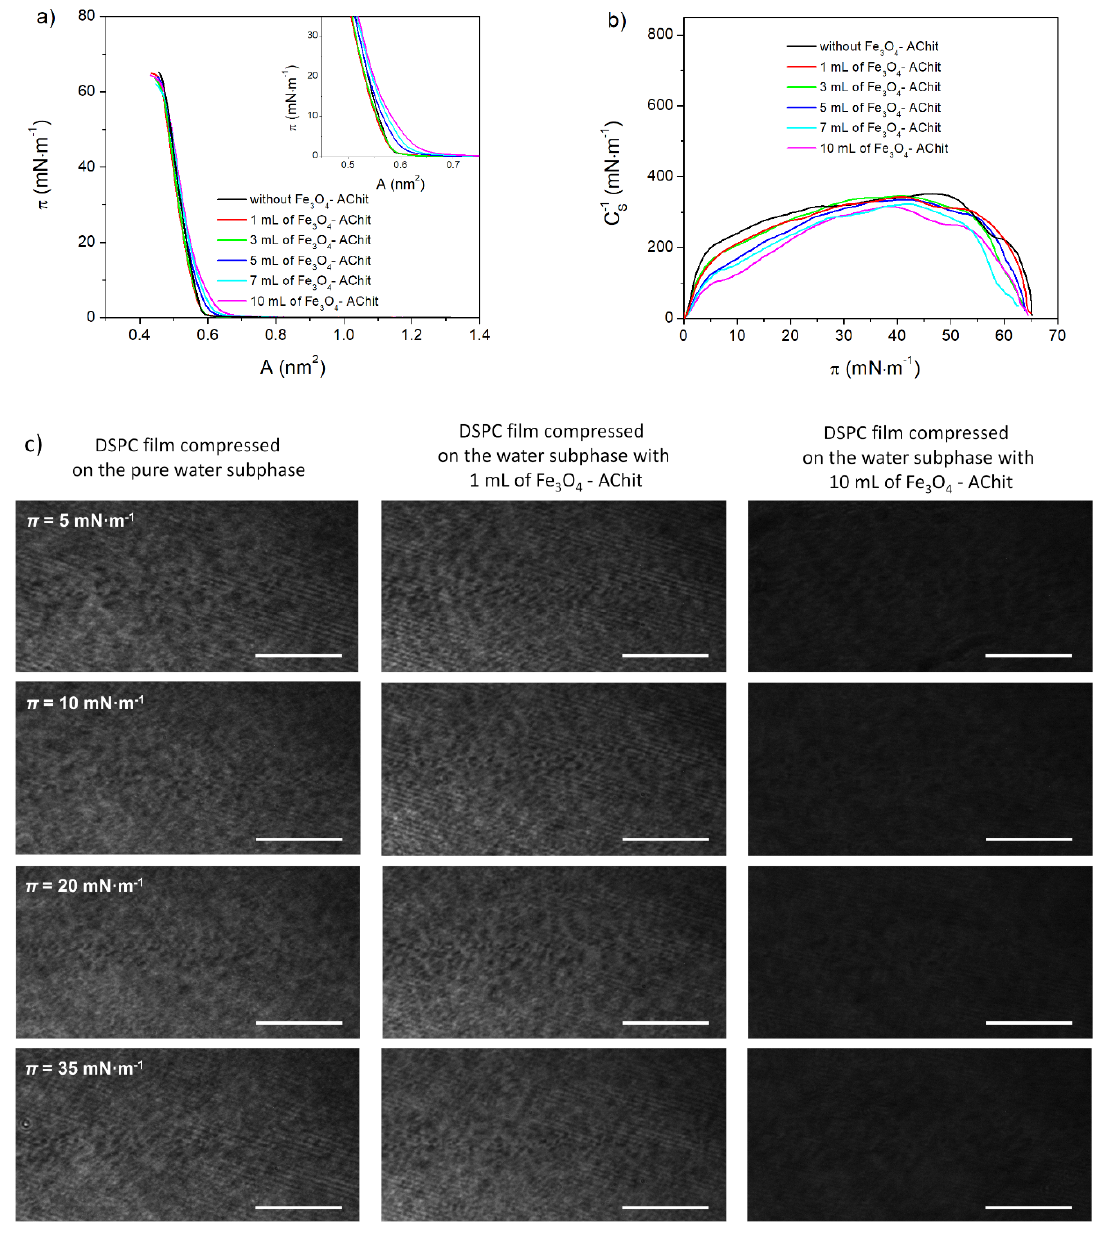
Figure 3. π -A isotherms ( a ), C S − 1 - π dependences ( b ), and BAM images ( c ) recorded during compression of the DSPC monolayers on the water subphase with different concentrations of the Fe 3 O 4 -AChit nanoparticles. Length of scale bar in BAM images—100 μ m.